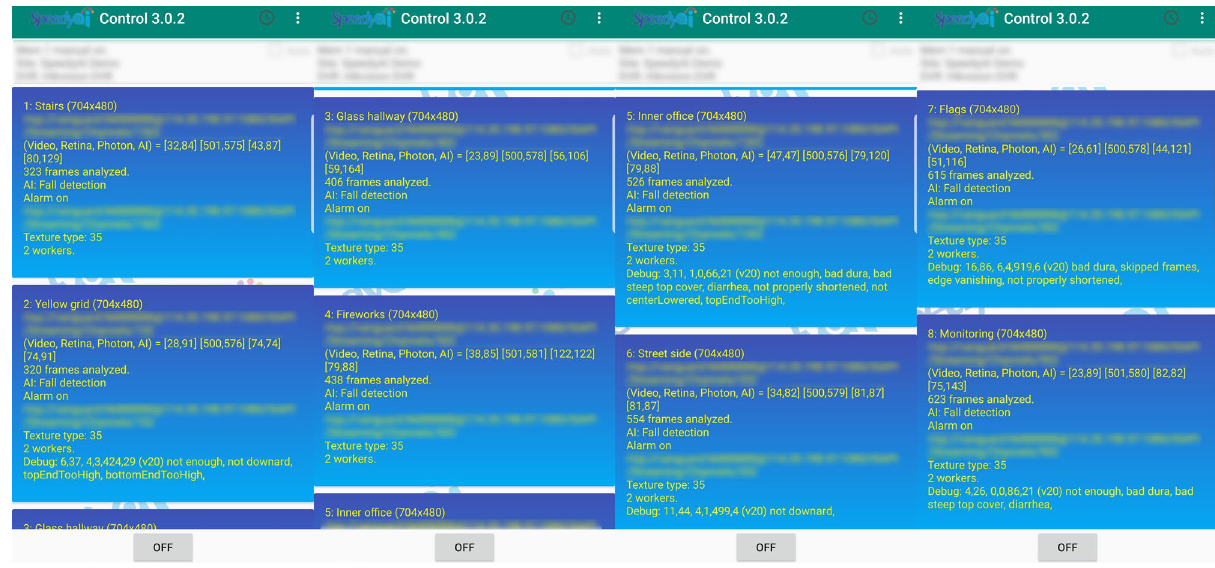
Figure 4. Four screenshots of the control panel demonstrating eight cameras monitored simultaneously by an eight-core Android TV box. The AI time (the last pair of the four sets of numbers, or the second row after the first redacted lines) indicates the minimum and maximum time in milliseconds during which the system processes a video frame. The average frame rate was around 10 FPS, meeting our detection requirement. This eight-core Amlogic S912 CPU loading during the monitoring period was between 43 and 85%. No falls happened, were detected, or reported during the testing period. The video signal was sent through